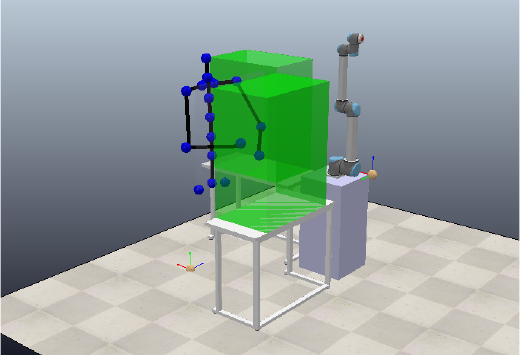
Figure 8. HRC team modelled using the CoppeliaSimEdu software package.